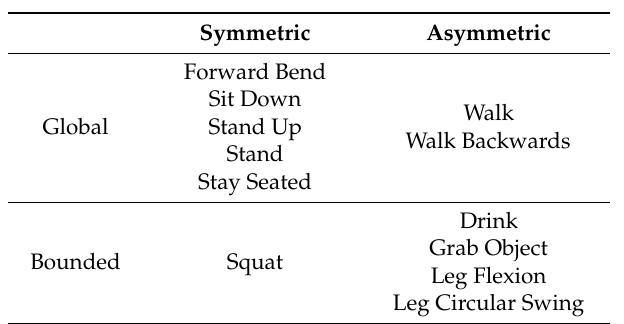
Table A1. Taxonomy of the considered activities by the E-BA-A during the